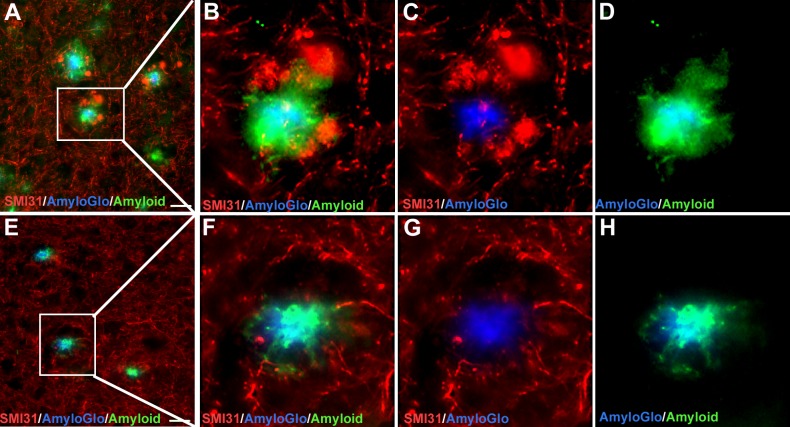
Decreased Aβ42 halo overlaps with the decreased incidence of DNs in FO treated mice.(A-D) Double staining of untreated 5xFAD mice brain sections with the 4g8 and SMI31 antibodies revealed that the areas with higher incidence of DNs display the greater total Aβ halo around the plaques (AmyloGlo+). (E-H) In the FO-treated 5xFAD animals the decreased surface of the Aβ halo overlaps with the decreased incidence of swollen, dystrophic neurites.